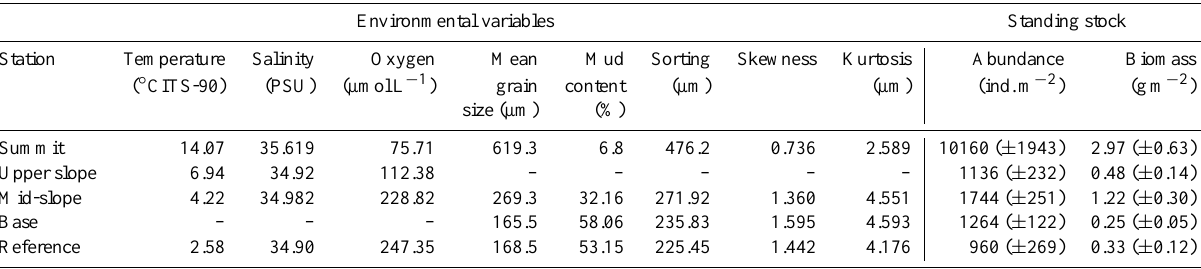
Table 2. Total abundance (ind.m − 2 ) and biomass values (gm − 2 ) per depth station (standard error values included). Environmental variables also included ∗ : temperature ( ◦ C ITS-90), salinity (PSU), oxygen (µmolL − 1 ), sediment characteristics: mean grain size (µm), mud content (%), sorting, skewness, kurtosis.